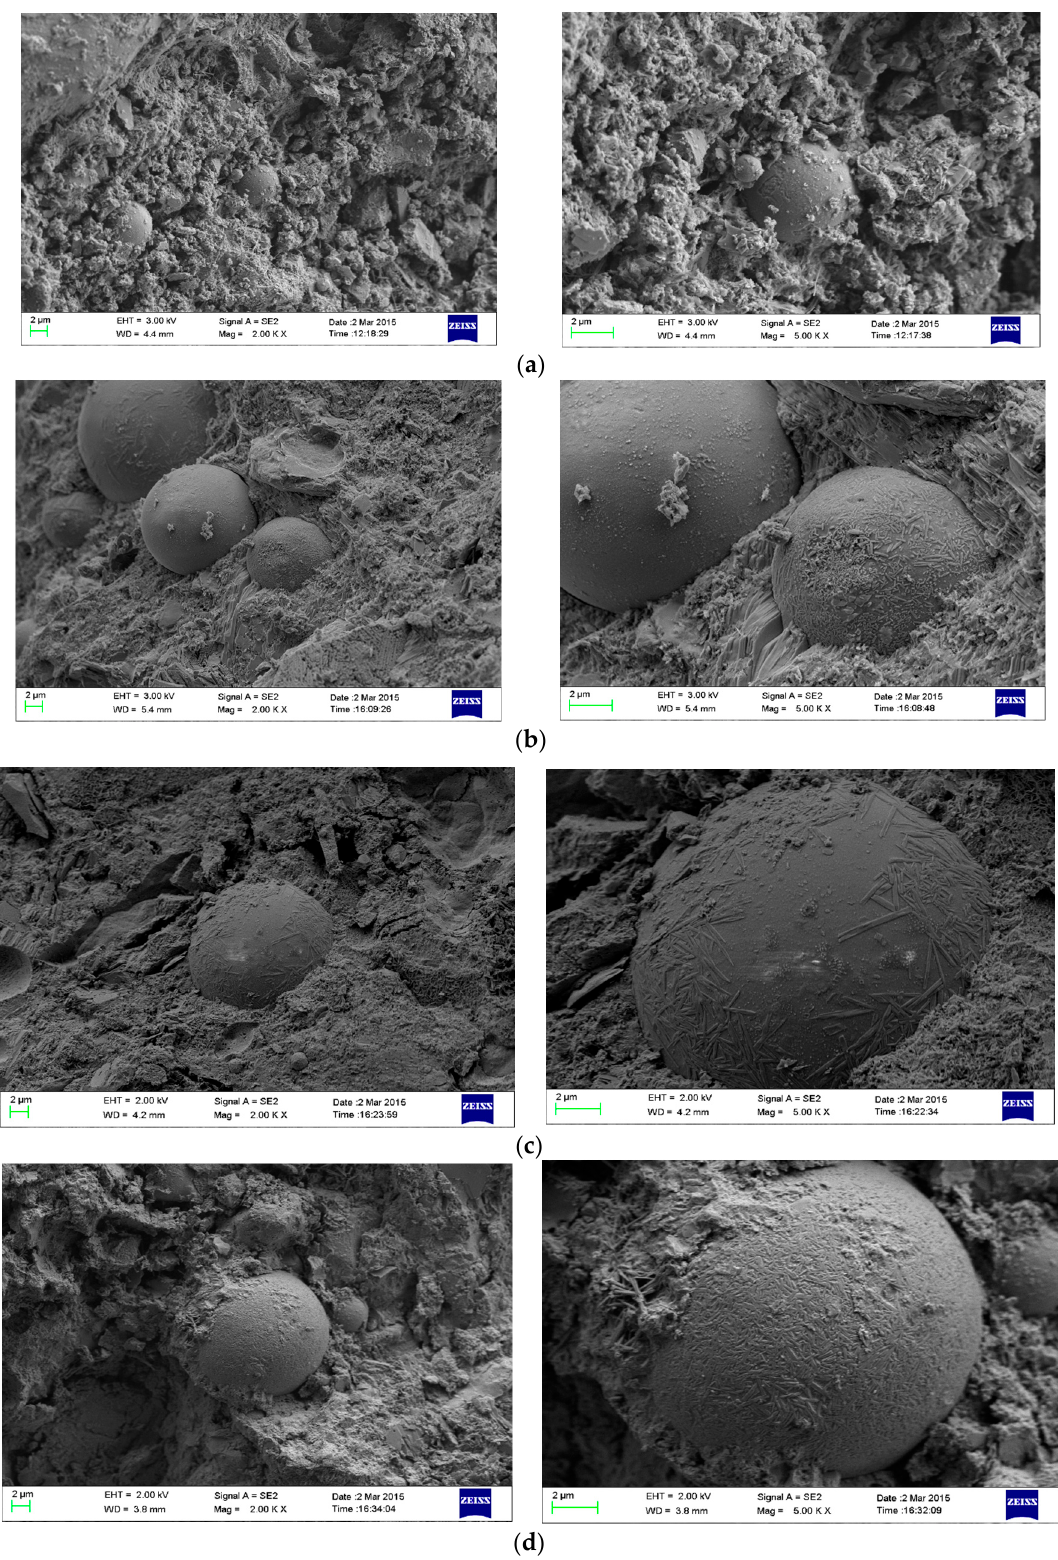
Figure 9. SEM image of cement paste with addition of SAP at 56 days: ( a ) PC-Z; ( b ) S02b-0; ( c ) S02b-10; ( d ) S02b-10K, S02b-10 and S02b-10K are pre-absorbed, and S02b-0 is non-absorbed.